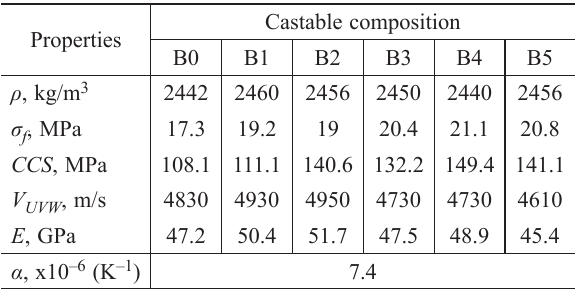
Table 3. Properties of castable samples after heating at a temperature of 950 °C